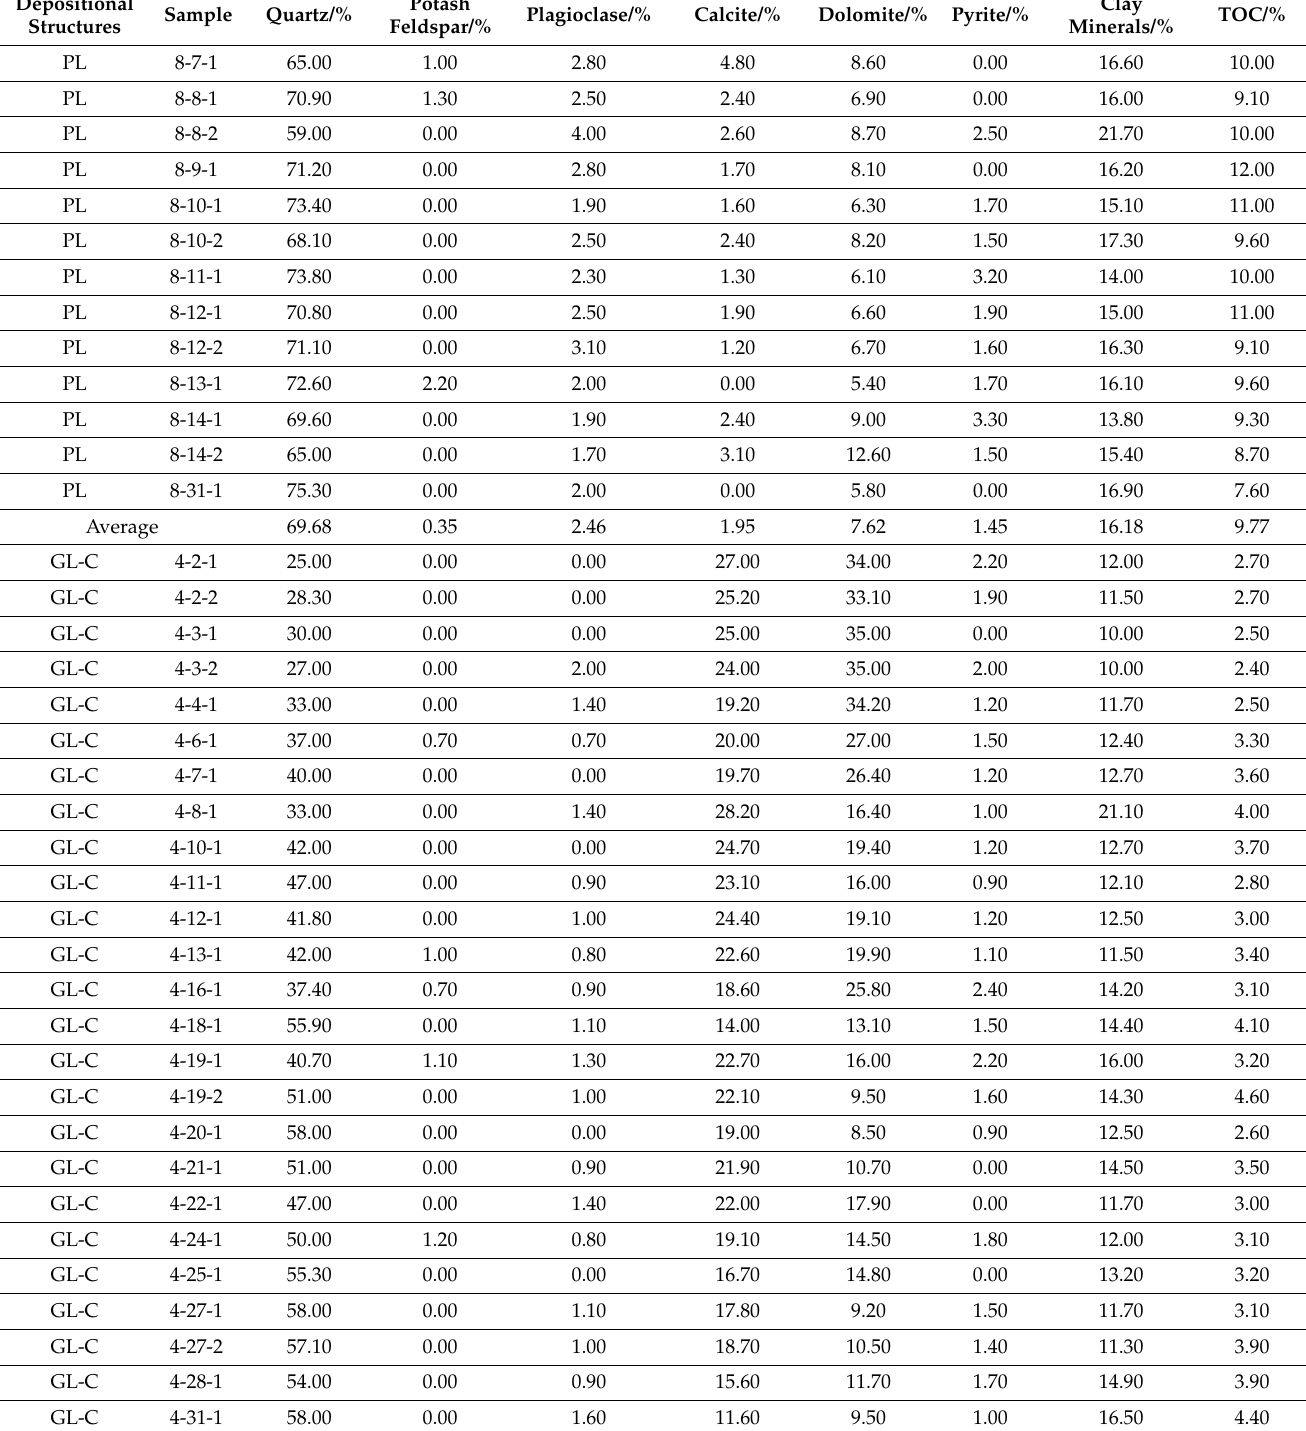
Table A1. Mineral components and total organic carbon content (%) of shale with various deposi- tional structures from the Wufeng–Longmaxi shale at the Shuanghe outcrop in the Sichuan Basin of southwestern China. The location of the outcrop is shown in Figure 1 and the sample depth is shown in Figure 2 (See